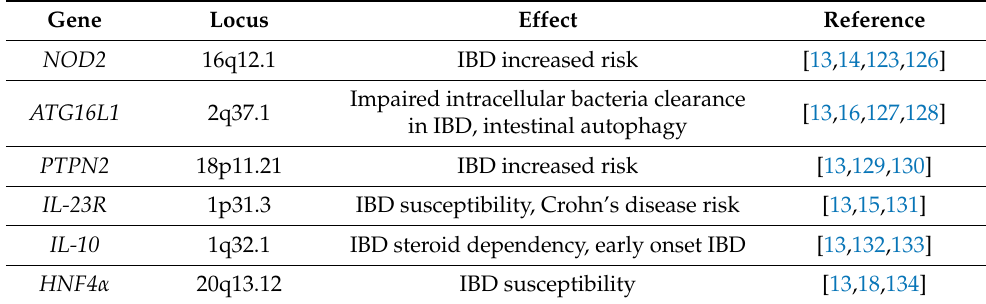
Table 2. Genes related to Inflammatory Bowel Disease. Gene Locus